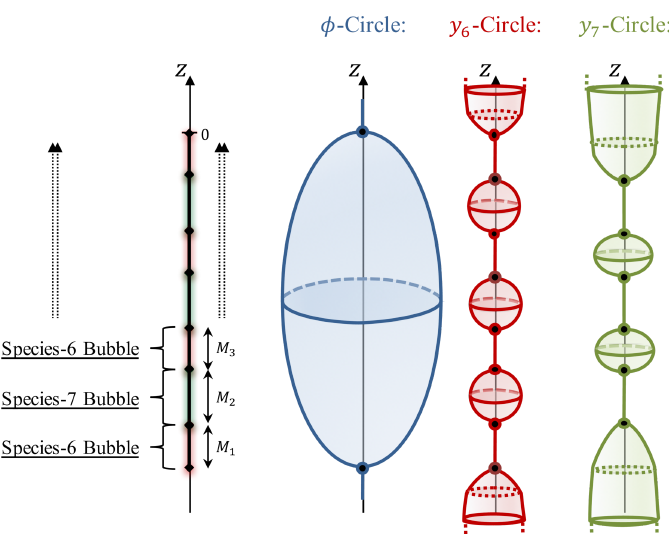
Figure 8 . Description of a chain of smooth D1-D5-KKm and KKm bubbles in type IIB and the behavior of the φ , y , and y circles on the z -axis (the other fibers have finite size everywhere). The 6 7 species- k bubble rod corresponds to the degeneracy of the y -circle as an origin of a R 2 . k weights (3.15) and a D1-D5-KKm bubble given by (3.32). Such configurations are